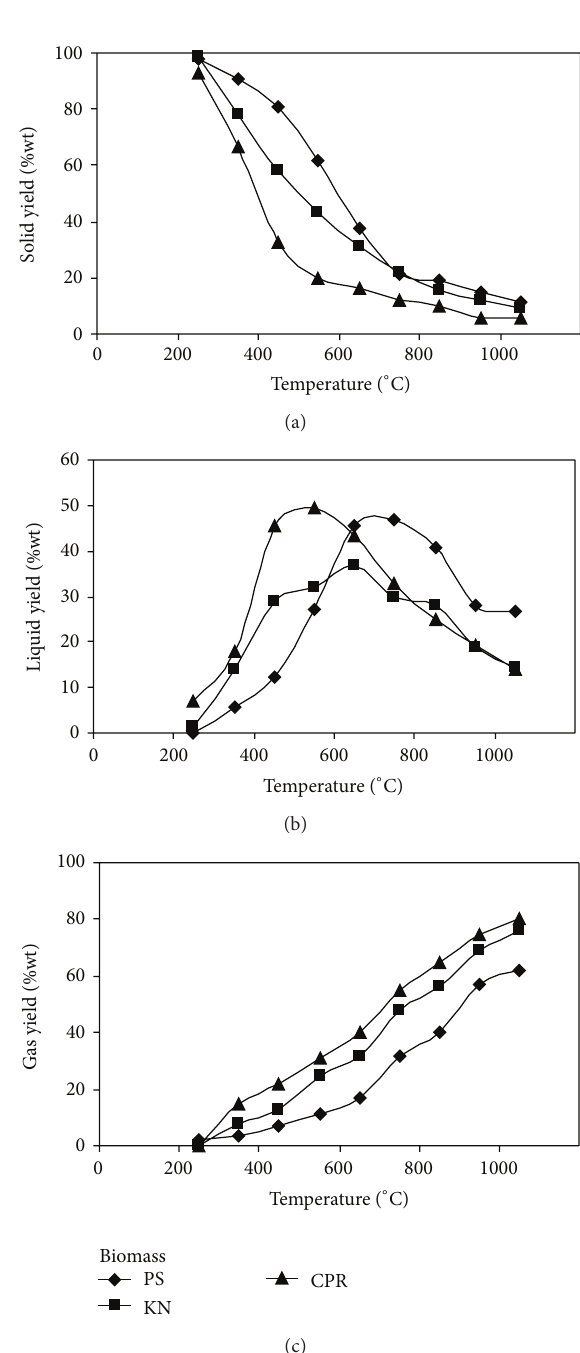
Figure 5: Effect of biomass type and pyrolysis temperature on (a) solid yield, (b) liquid yield, and (c) gas yield (biomass feed rate 0.6 g/min, sweep gas flow rate 200 mL/min, and particle size of 0.28